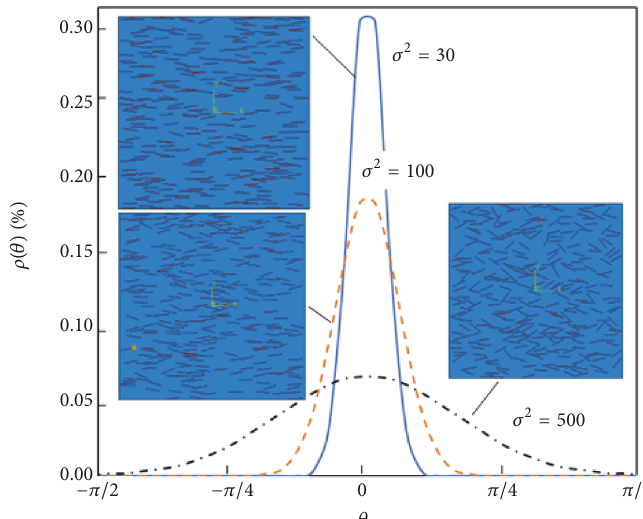
Figure 4: Effect of variance 𝜎 2 of the normal probability density function on fiber distribution: 𝜃 = 0 , 𝜇 = 0 .